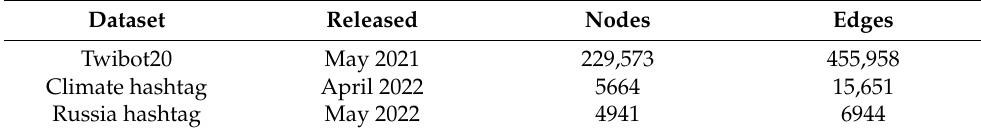
Table 3. Summary statistics for the used